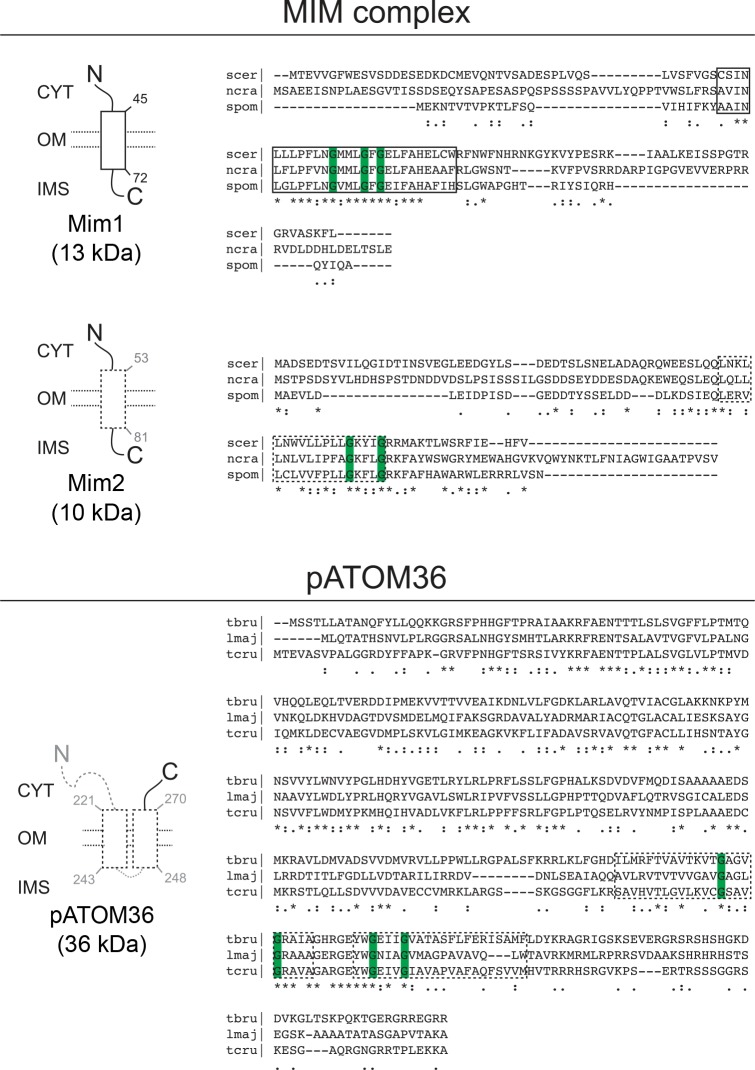
Topologies and protein sequence alignments of Mim1, Mim2 and pATOM36.Left panels: Schematic representation of the experimentally determined and predicted topologies of Mim1, Mim2 and pATOM36. The transmembrane segment (TMS) of Mim1 has been experimentally characterised (solid line), whereas those of Mim2 and pATOM36 are predicted by PolyPhobius with TOPCONS (dashed lines). The amino acid positions of the TMSs are illustrated and the protein sizes are in brackets. CYT, cytosol; OM, outer mitochondrial membrane; IMS, intermembrane space. Right panels: Multiple protein sequence alignments of Mim1, Mim2 and pATOM36. Verified and predicted TMSs are highlighted by solid and dashed lines, respectively. Conserved glycine residues are marked in green. scer, Saccharomyces cerevisiae; ncra, Neurospora crassa; spom, Schizosaccharomyces pombe; tbru, Trypanosoma brucei; lmaj, Leishmania major; tcru, Trypanosoma cruzi.